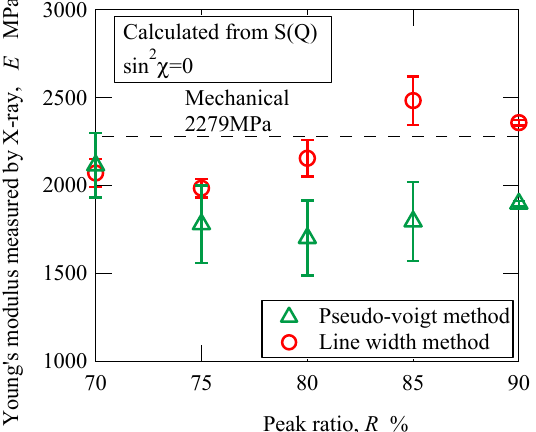
Figure 8. Relation between average Young’s modulus determined from all the four stress levels and peak ratio.